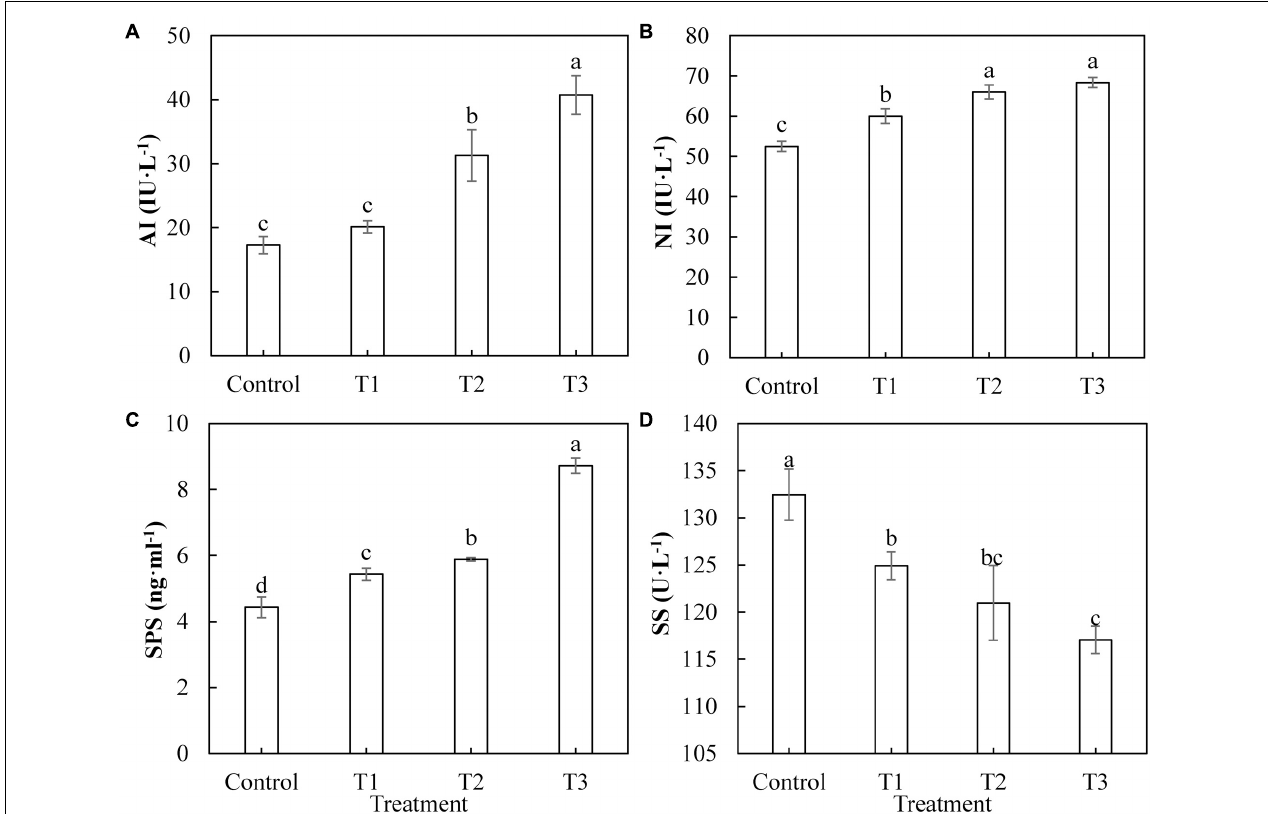
FIGURE 7 | Effects of supplemental LED light duration on the activities of sugar metabolism-related enzymes: acid conversion enzyme (A) , neutral invertase (B) , sucrose phosphate synthase (C) , and sucrose synthase (D) in cucumber leaves. After LED light supplement treatment for 30 days, 10 pieces of the third leaf from the top of cucumber were selected from each treatment, washed and dried immediately, and then put into liquid nitrogen to prepare for the determination of activities of the enzymes related to sugar metabolism. Values are expressed as mean ± SE ( n = 3). Bars that are significantly different based on the Duncan’s multiple range test ( p < 0.05) are indicated with different lowercase